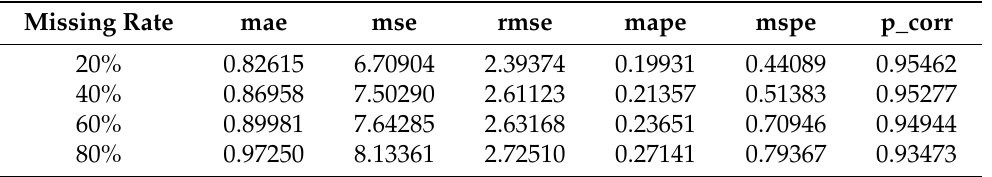
Table 2. The results of the informer-WGAN on the electricity dataset. Missing Rate